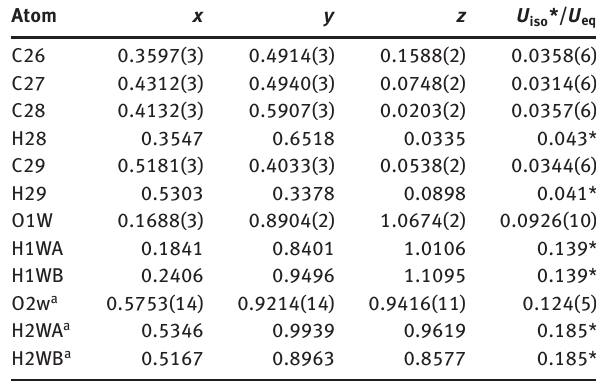
Table 2: Fractional atomic coordinates and isotropic or equivalent isotropic displacement parameters (Å 2